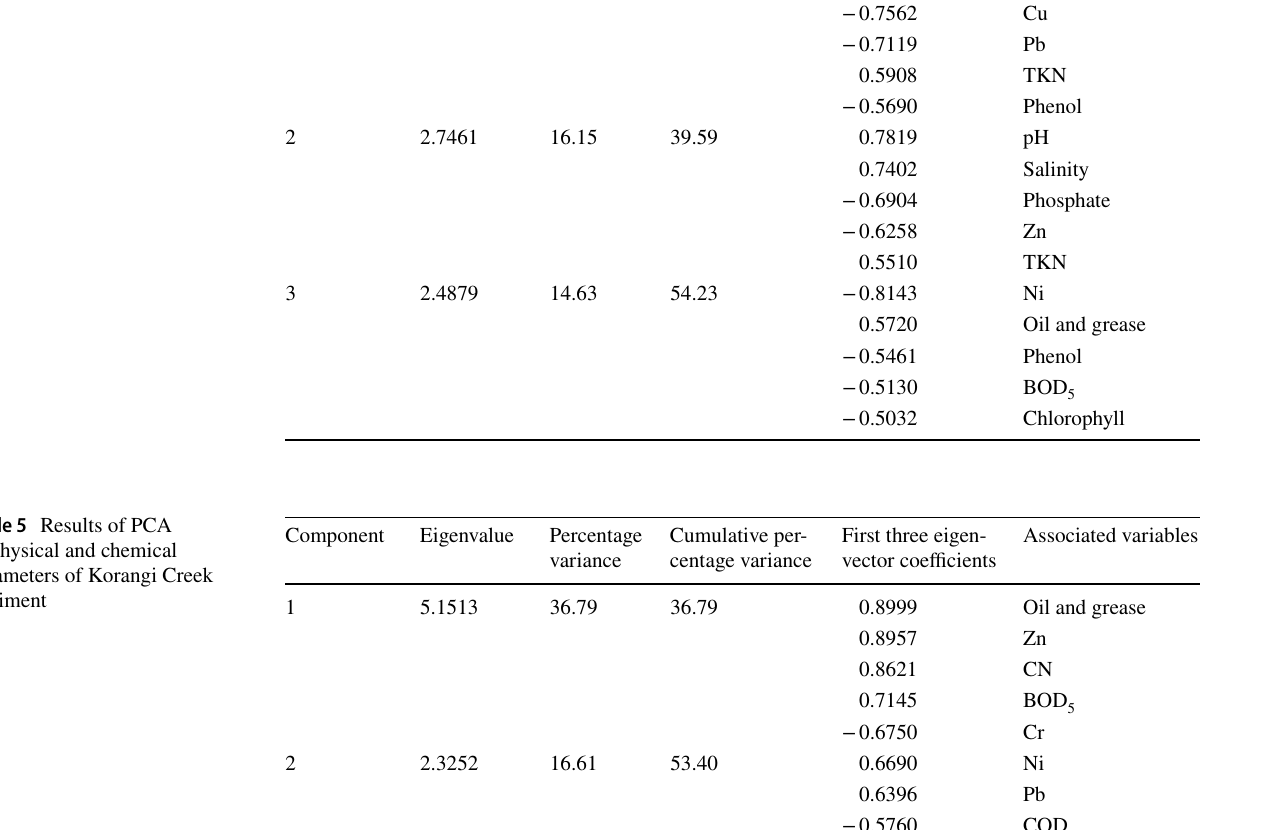
of physical, chemical and microbiological parameters of